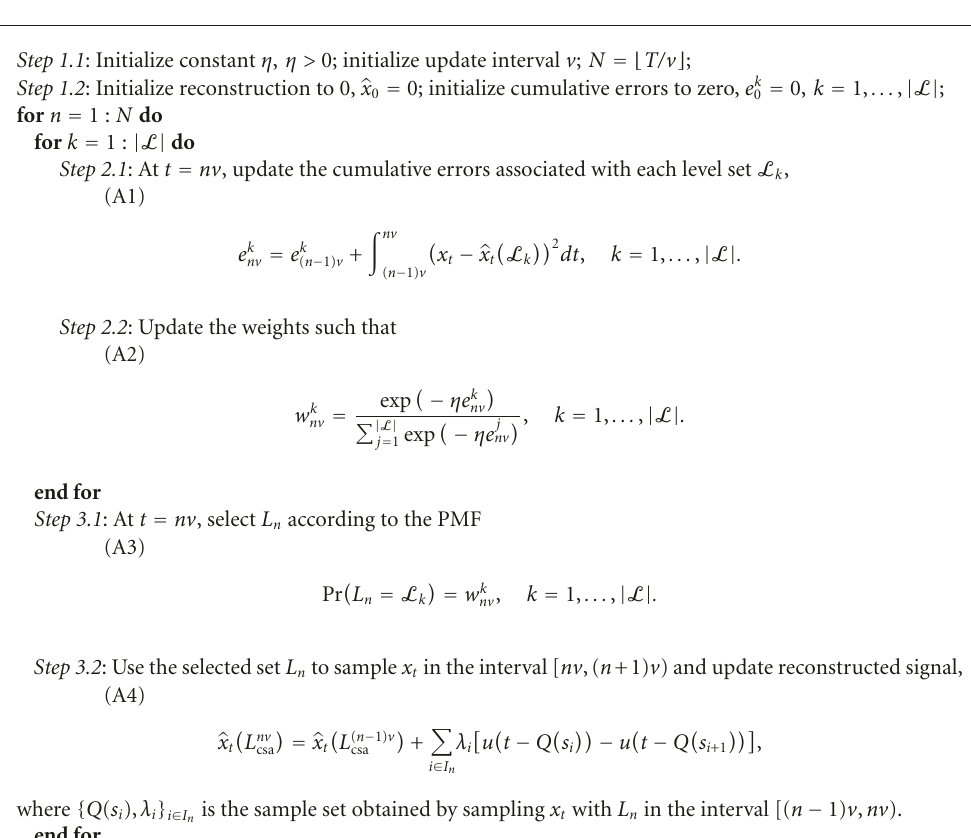
Algorithm 1: Continuous-time sequential algorithm (CSA).